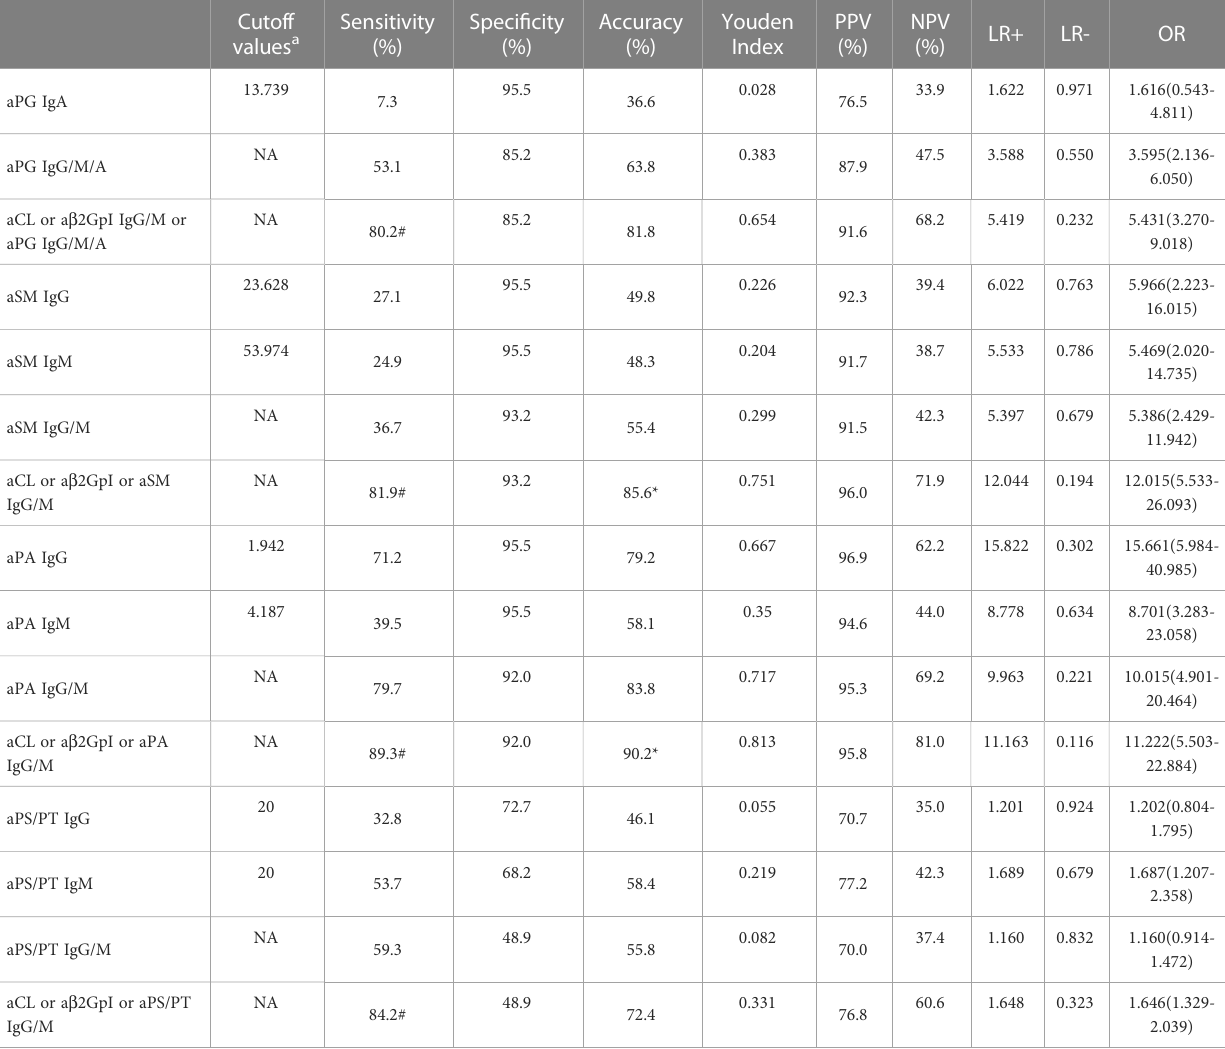
Figure 2 demonstrated the number of positive non-criteria aPLs in the different clinical groups. Patients from the PAPS and SAPS groups had a signi fi cantly higher number of positive aPLs compared